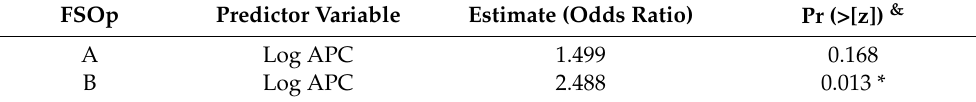
Table 4. Generalized linear model for predicting L. monocytogenes on surfaces in FSOp-A and B. FSOp Predictor